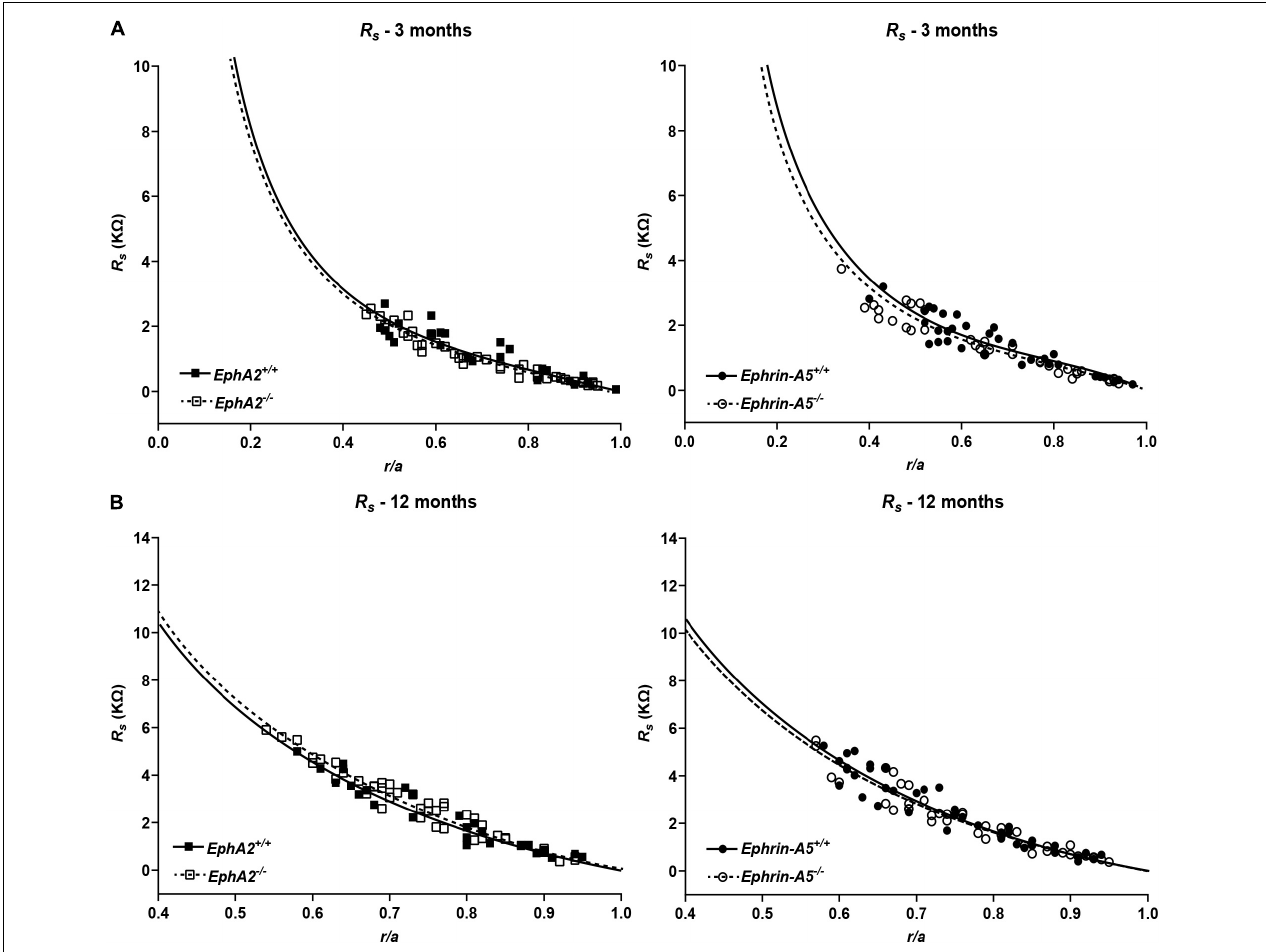
FIGURE 7 | Series resistance measurements in lenses from 3- and 12-month-old control, EphA2 − / − and ephrin-A5 − / − mice. (A) Series resistance ( R s ) in lenses from 3-month-old EphA2 + / + (black squares with solid fit line), EphA2 − / − (open squares with dashed fit line), ephrin-A5 + / + (black circles with solid fit line), and ephrin-A5 − / − (open circles with dashed fit line) lenses as a function of distance from lens center ( r / a ), where r (cm) is actual distance and a (cm) is lens radius. There are no obvious differences in resistance between control and KO lenses ( n ≥ 6). (B) Series resistance ( R s ) in lenses from 12-month-old EphA2 + / + (black squares with solid fit line), EphA2 − / − (open squares with dashed fit line), ephrin-A5 + / + (black circles with solid fit line), and ephrin-A5 − / − (open circles with dashed fit line) lenses as a function of distance from the lens center. There are no significant differences in resistance between control and KO lenses ( n ≥